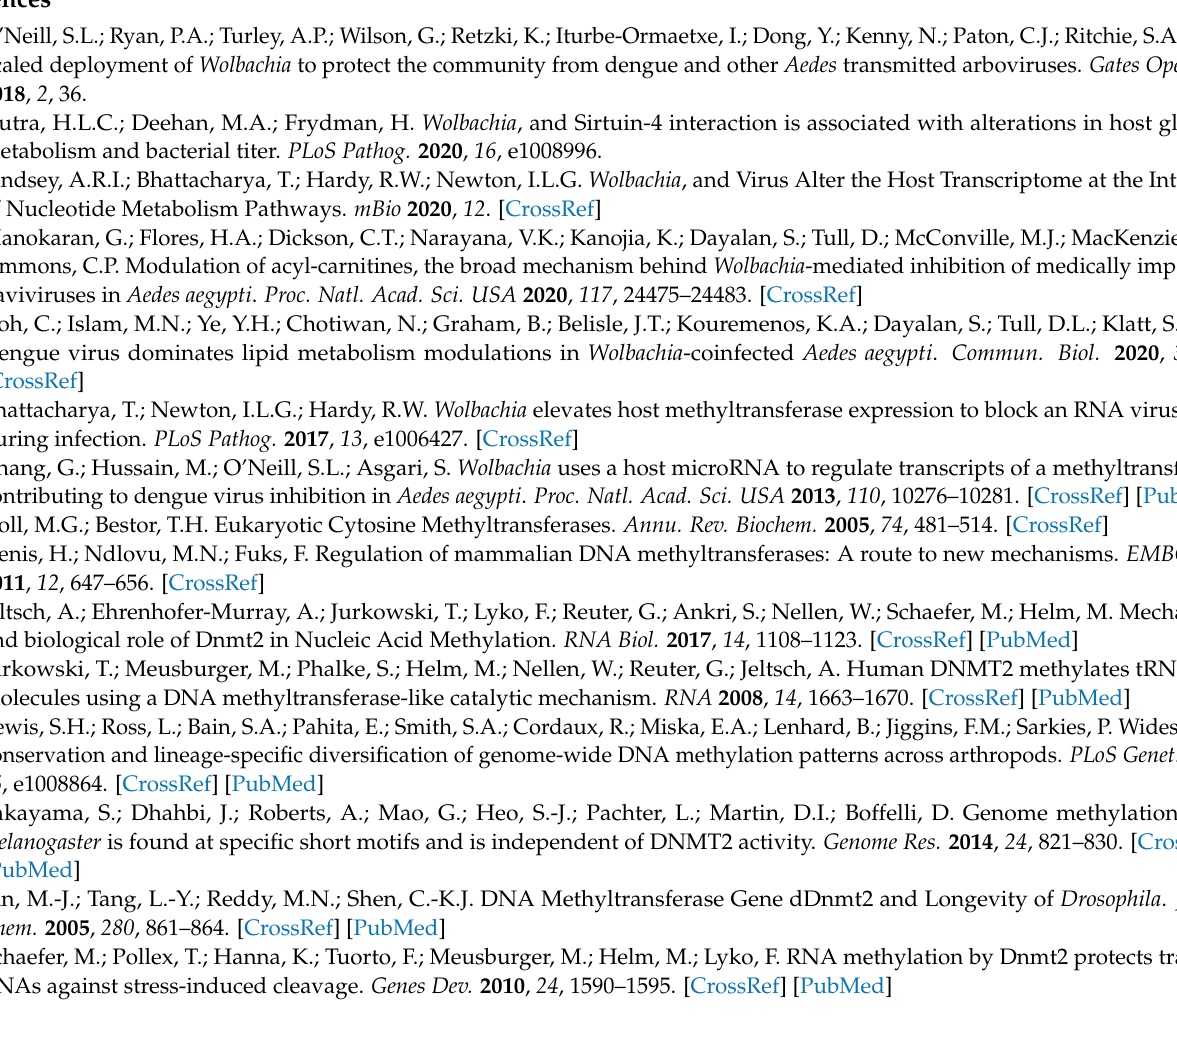
knockdown flies. Figure S6: Effect of heterologous DNMT2 expression on Wolbachia in mosquito cells. Figure S7: Predicted role of miRNAs in regulation of Drosophila DNMT2 and IPOD. Table S1: Primers used in this